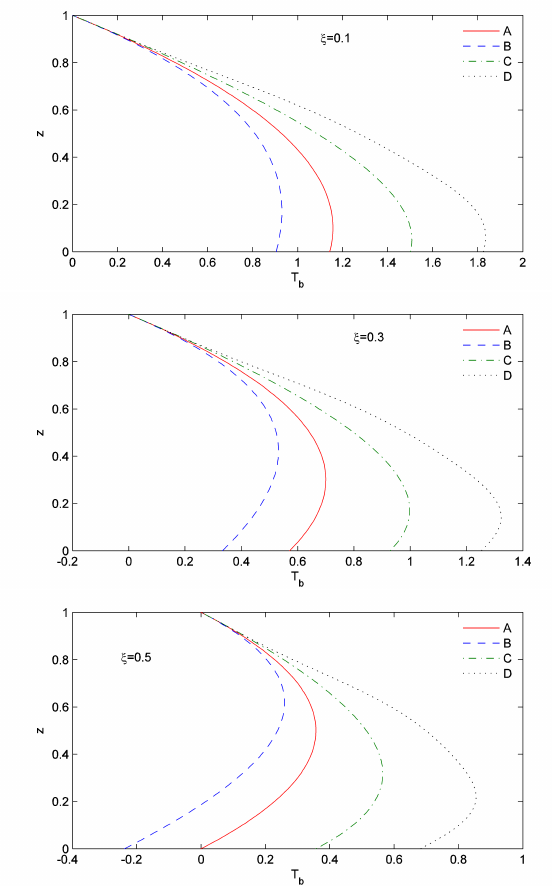
Fig. 2: Basic temperature profiles T b with fluid layer z